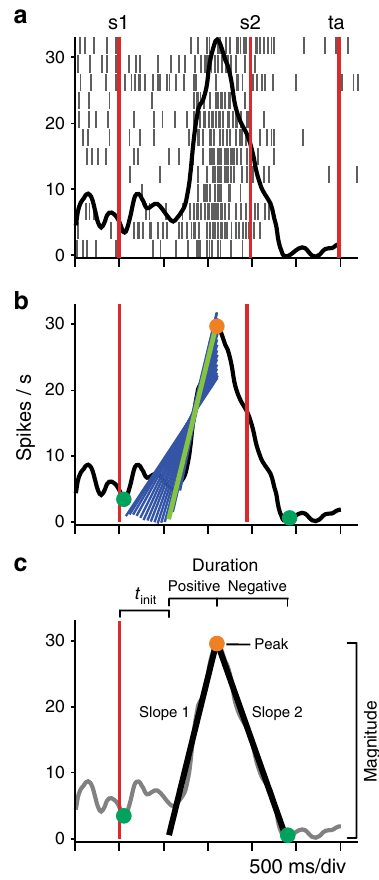
Fig. 3 Iterative algorithm used to fi nd the best regression model to describe the increase or decrease of instantaneous activity of boundary neurons over time with respect to a sensory event. a Raster plot and mean spikes density function (SDF; σ = 30 ms; black function) of the boundary cell in Fig. 2, for block 3 and the test interval duration of 1470 ms, aligned to the presentation of the fi rst stimulus (s1). b A series of linear regression functions are displayed (blue lines), including the best model (thicker green line) identi fi ed by the algorithm. c Parameters extracted from the linear regression model for the identi fi cation of bisection neurons